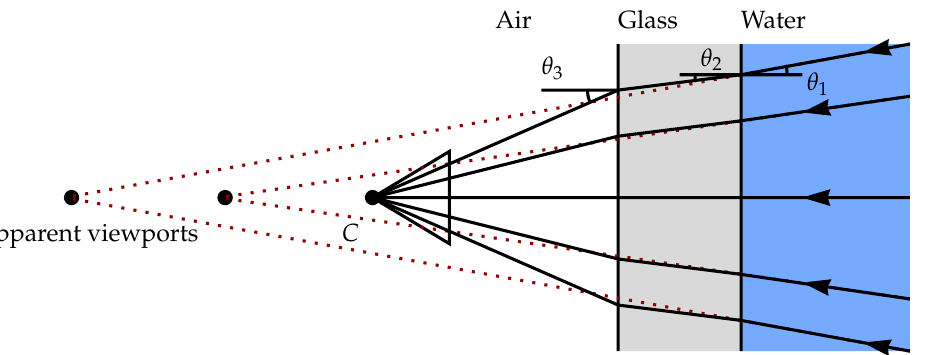
Figure 1. Refraction caused by the air-glass (acrylic)-water interface. The extension of the refracted rays (dashed lines) into air leads to several intersection points, depending on their incidence angles and representing multiple apparent viewpoints. Because of refraction, there is no collinearity between the object point in water, the center of projection of the camera and the image point